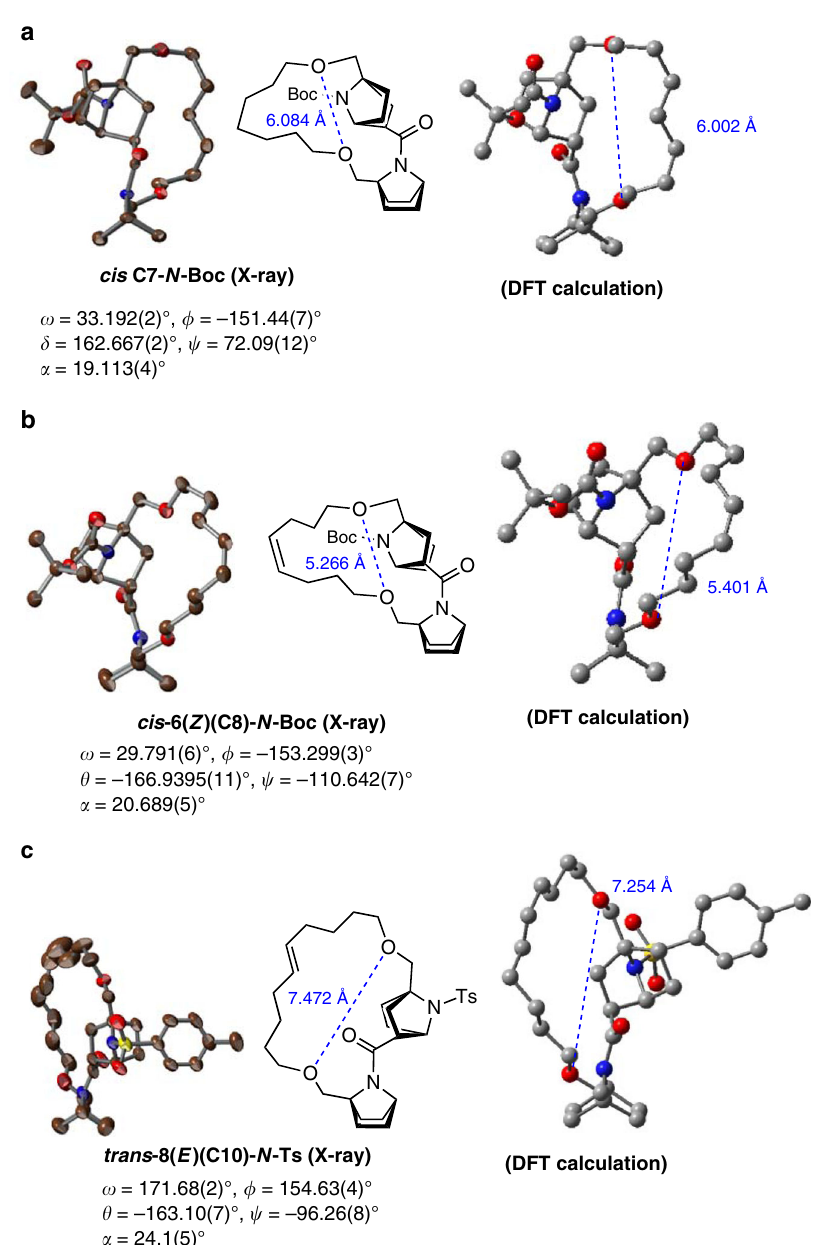
Fig. 5 ORTEP drawings (50% probability) of the crystal structures of some derivatives. a The crystal structure of N -Boc derivative of C7 in the cis amide form. b The crystal structure of N -Boc derivative of 6 ( Z ) ( C8 ) in the cis -amide form, and c the crystal structure of N -tosylated derivative of 8 ( E ) ( Ts-8 ( E ) ( C10 )) in the trans -amide form. All three structures were crystallized as racemates in centrosymmetric space groups. DFT-optimized structures are also shown. The distance between the ether oxygen atoms in the linker is shown in blue. Brown/gray: carbon atom; blue: nitrogen atom; red: oxygen atom. All hydrogen atoms are omitted for